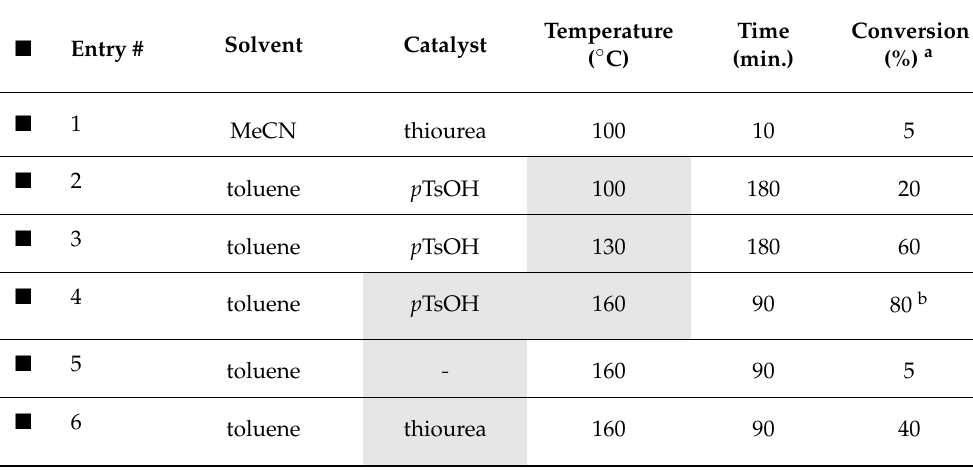
Scheme 3. Synthesis of KYNA TRAMs through indole-based Mannich products. Table 1. Optimization of the synthesis of 7 .